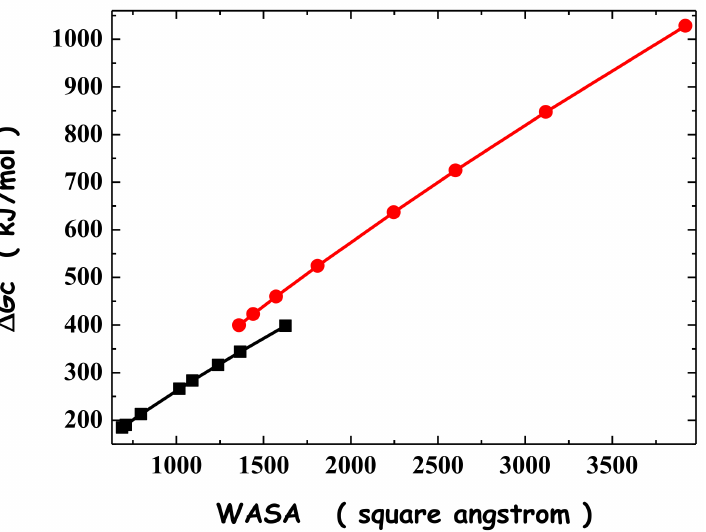
Figure 3. Plot of ∆ G C versus WASA for the two sets of cavities listed in Table 3 (in each set, all of the cavities have the same van der Waals volume). The two lines simply connect the points; they are not the result of a linear